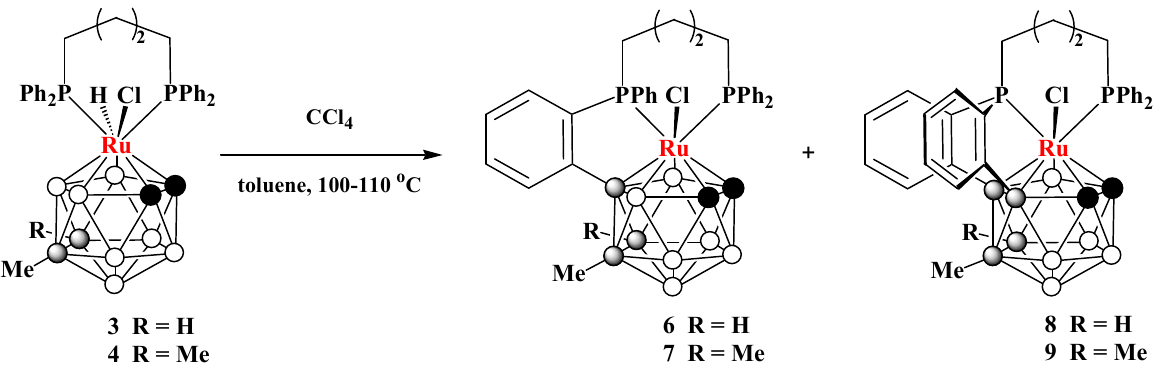
Figure 1. 31 P NMR spectra of complexes 3 and 4 in CD 2 Cl 2